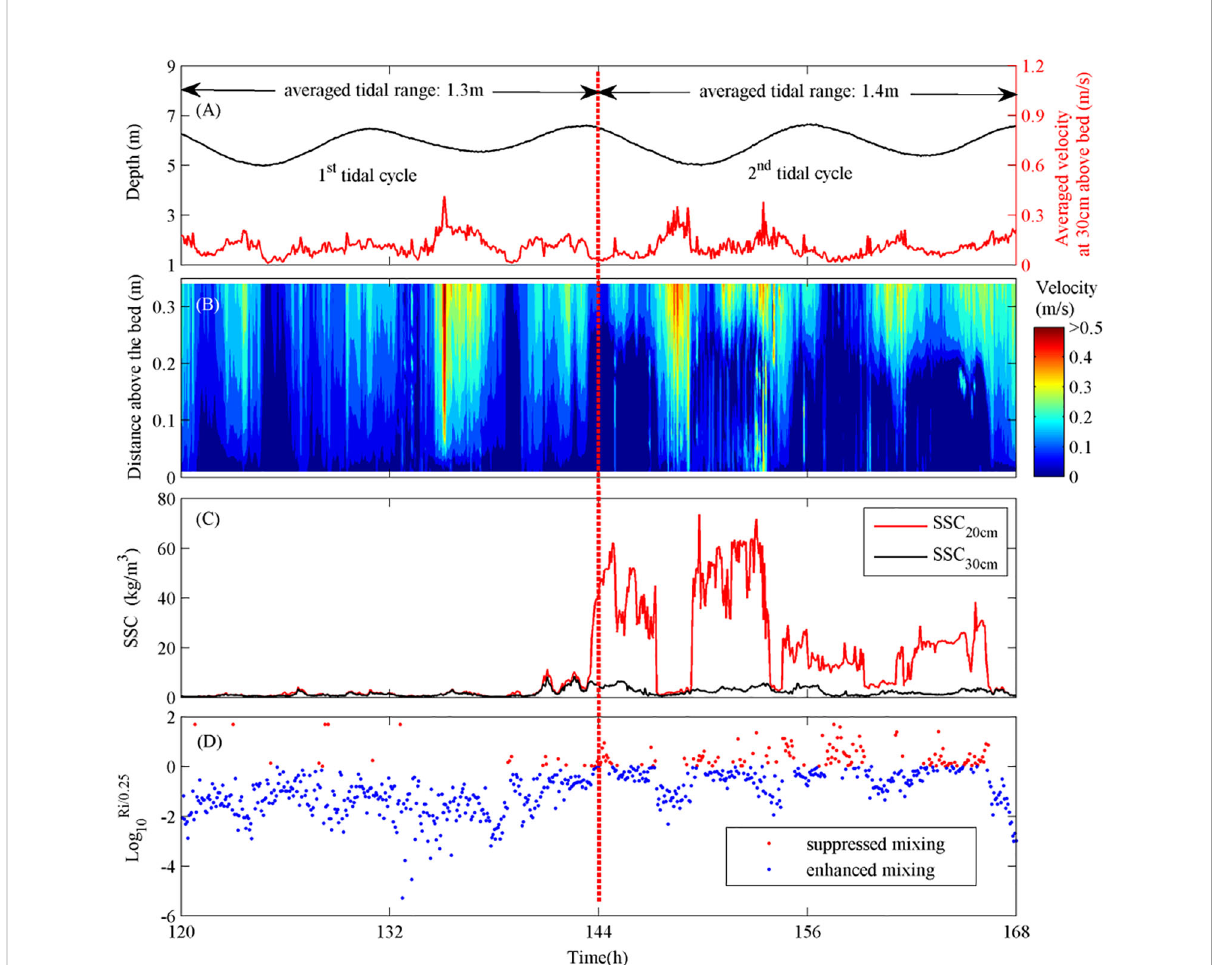
FIGURE 7 The hydrodynamic and mixing condition within 0.3 mab under the impact of fl uid mud during our observation period (Phase III), which includes the times series of vertical-averaged velocity within 0.3 mab and the water depth (A) , the pro fi les of current velocity within 0.3 mab (B) , the SSC at 0.2 and 0.3 mab (C) and the mixing condition within 0.3 mab described by gradient Richardson number (D)